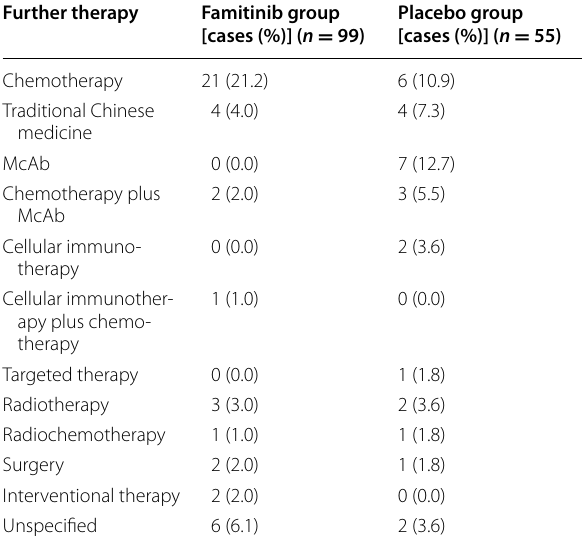
Table 3 The further anti-tumor therapy following the com- pletion of famitinib or placebo treatment in the full analy-